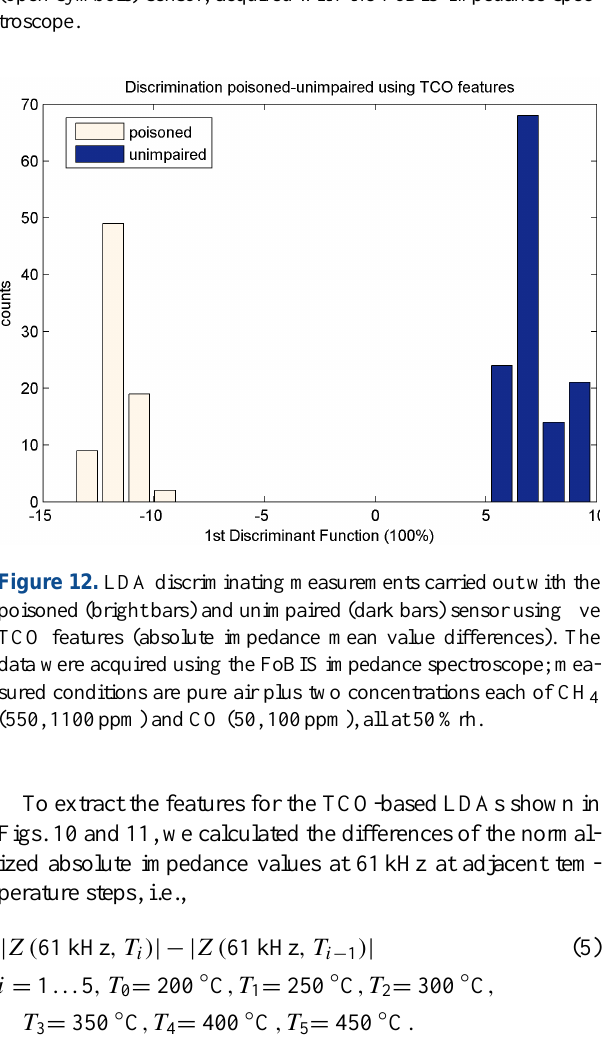
Figure 10. LDA of five TCO features (absolute impedance value differences) for unimpaired (solid symbols) and poisoned (open symbols) sensor, acquired with Agilent 4294A impedance analyzer.